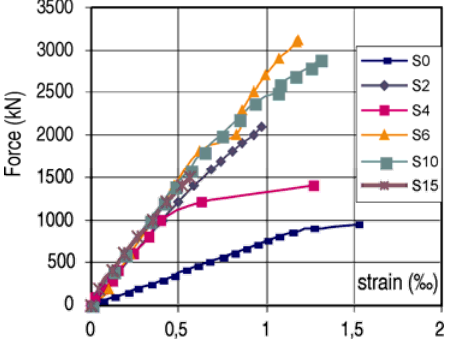
Fig 13 . Strains of construction steel in different testing types of columns (blue line for steel column S0)